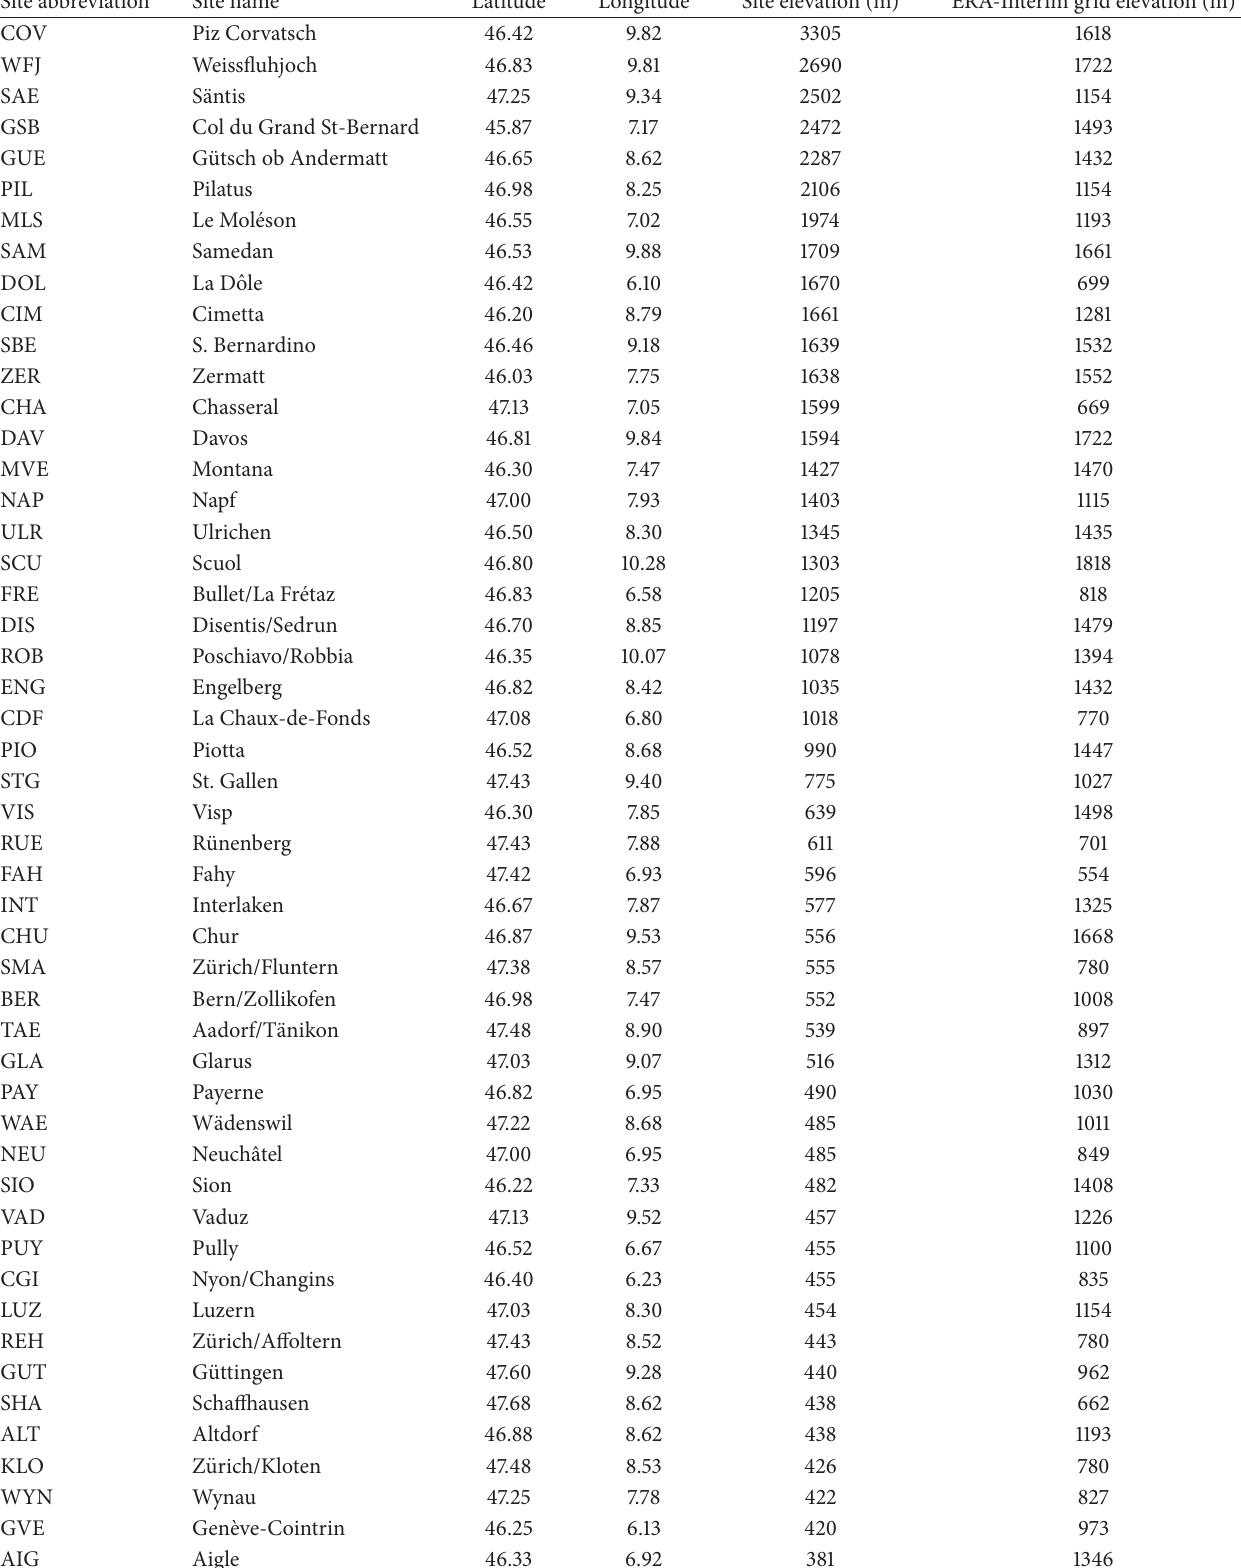
Table 2: Test sites information. ERA-Interim grid height is also